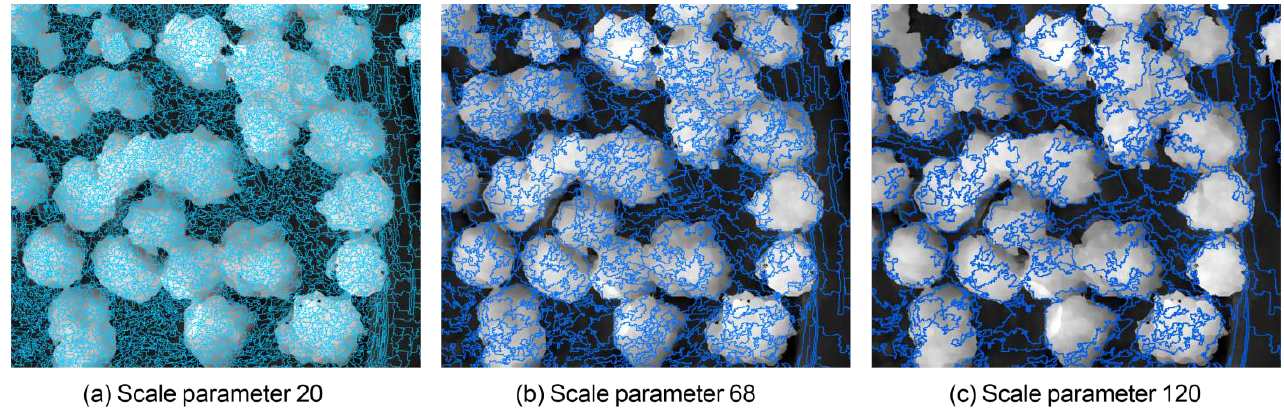
Figure 3. ESP segmentation effect of different scale parameters.